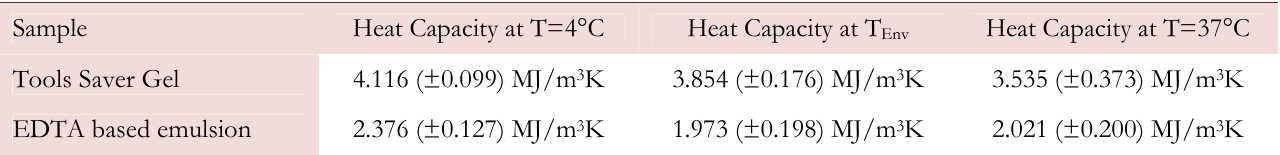
Table 2: Heat Capacity comparison between Tool Saver Gel and EDTA based emulsion.